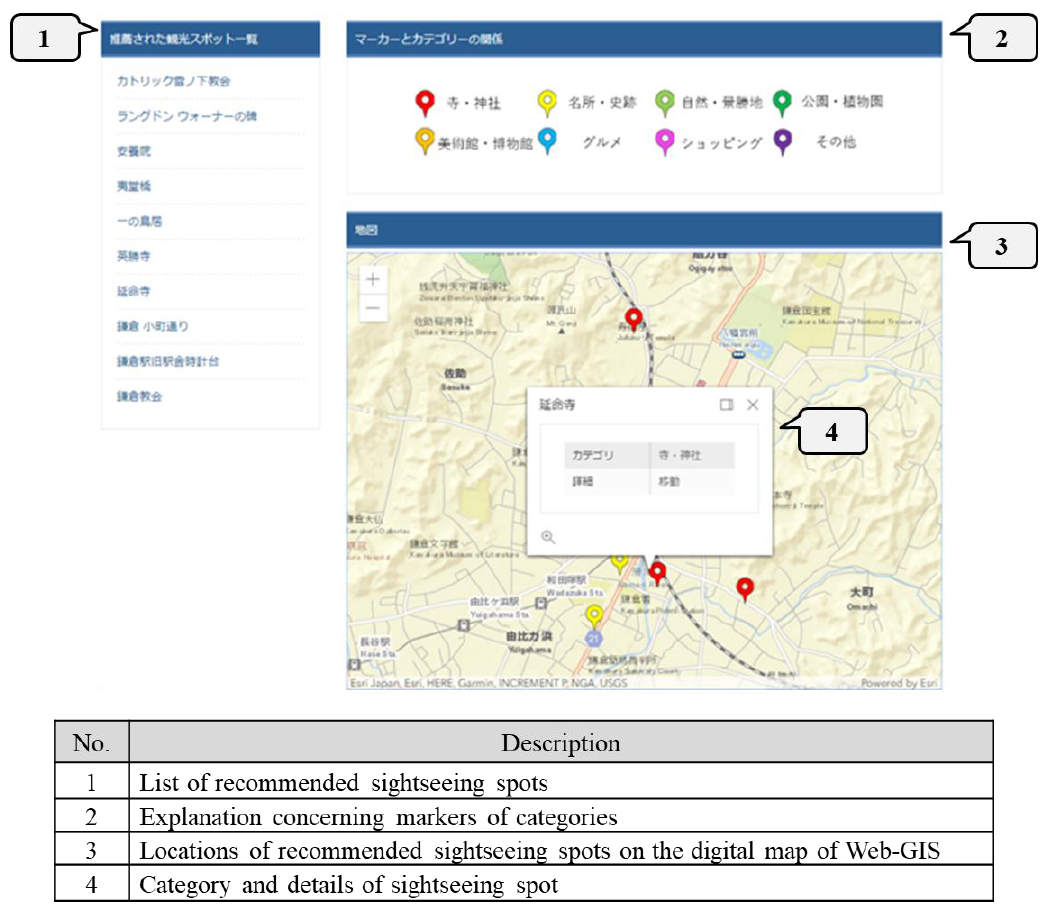
Figure 7. Page for recommendation results.